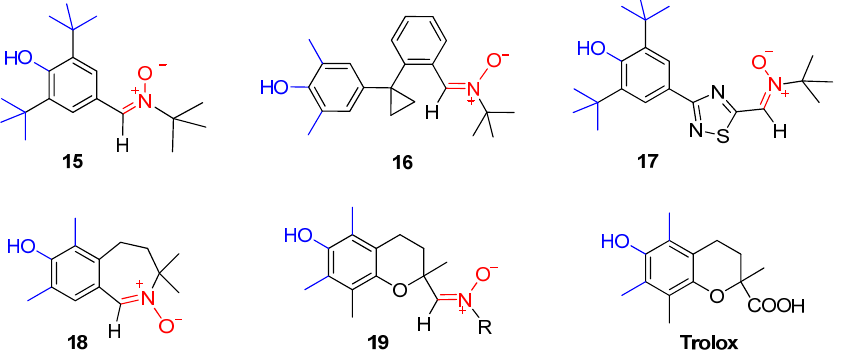
Scheme 3. Examples of spin traps, antioxidants, and neuroprotectors containing α , α′ -dialkyl–substituted phenolic or nitrone groups.